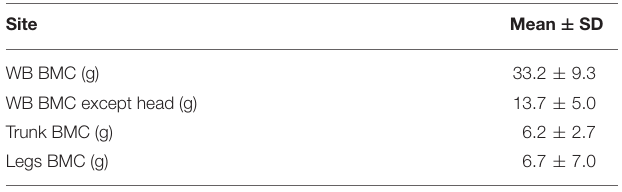
TABLE 1 | Baseline characteristics of the study subjects ( N = 45). Characteristics